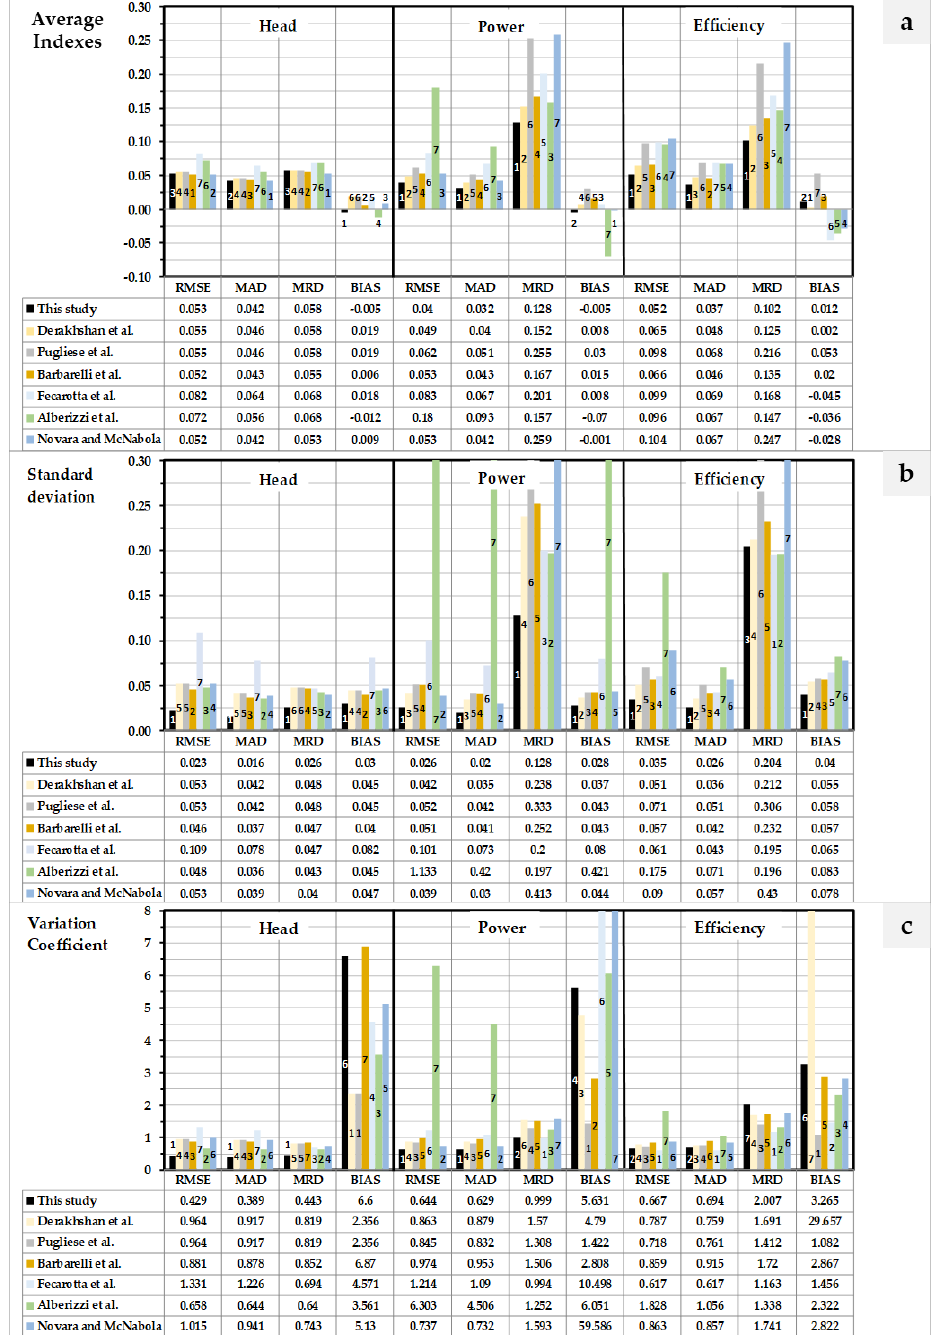
Figure 7. ( a ) Average indexes, ( b ) standard deviation and ( c ) variation coefficient in the prediction depending on the applied method. The number which is located in each bar (x) indicates the classified order of the method considering the rest of methods .